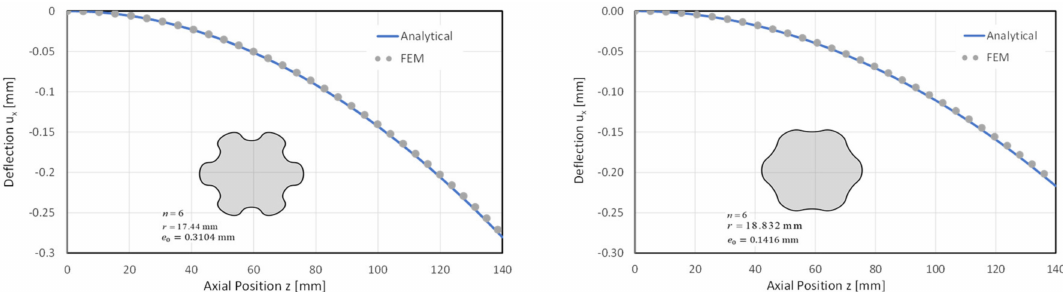
Figure 14. Shaft deflection of the M-04 [1] ( left ) and the modified profile [2] ( right ): comparison between the FE analysis results and the results based on Equation